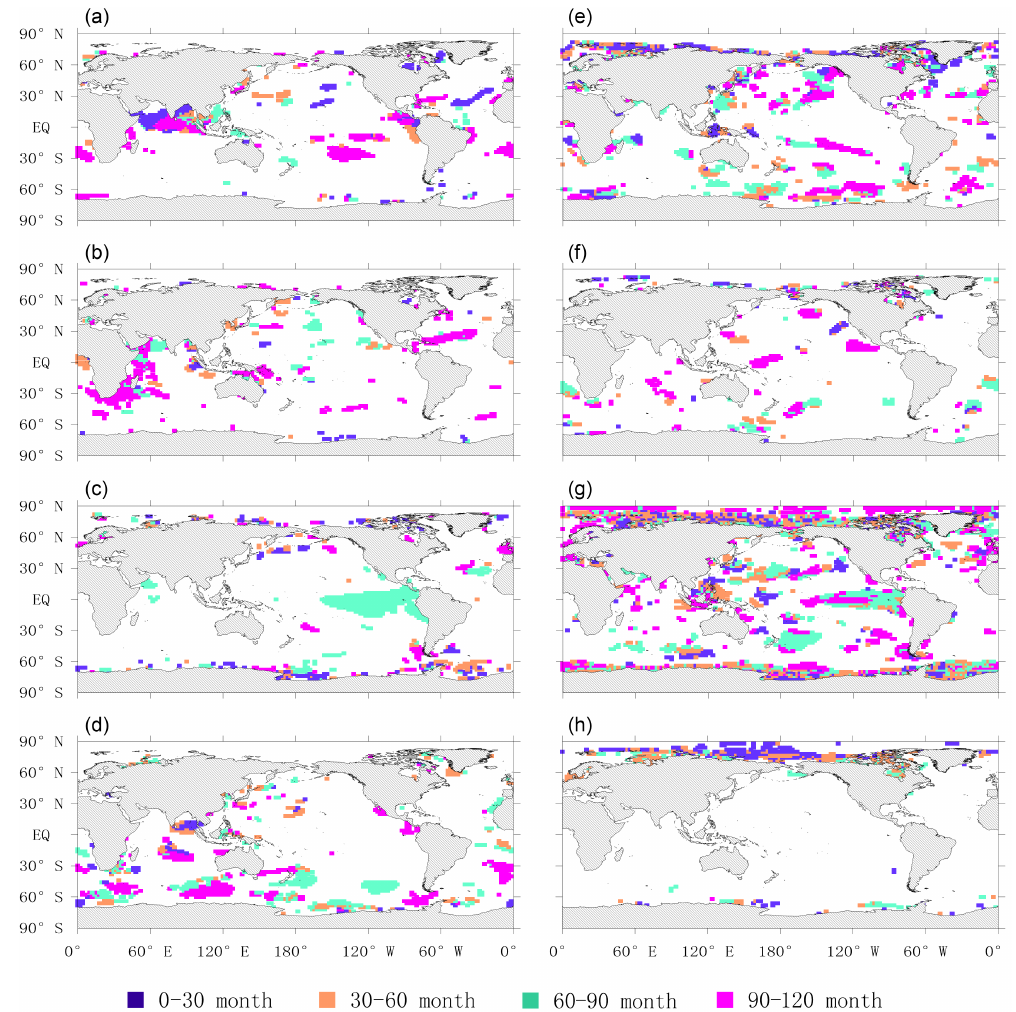
Figure 4. Spatial distribution of abrupt change duration in different periods: (a) is the abrupt change in 1878, (b) is the abrupt change in 1896–1898, (c) is the abrupt change in 1900–1903, (d) is the abrupt change in 1908–1909, (e) is the abrupt change in 1942, (f) is the abrupt change in 1976, (g) is the abrupt change in 1989–1999, and (h) is the abrupt change in